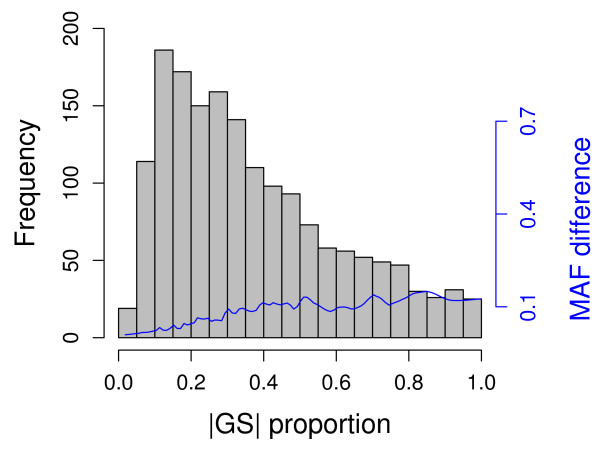
Summary of Genetic Score analysis. |GS| proportion was calculated by |GS|/(|BD| + |GS|) as shown in the x-axis. The histogram is a representation of |GS| proportion frequencies (indicated on the left-axis in black) underlying 1,689 SNP-GE pairs identified by CTWM-GS method. The blue line represents the smooth correlation between |GS| proportion and MAF (minor allele frequency) differences (indicated on the right-axis in blue) estimated by the Lowess method underlying the same 1,689 SNP-GE pairs.